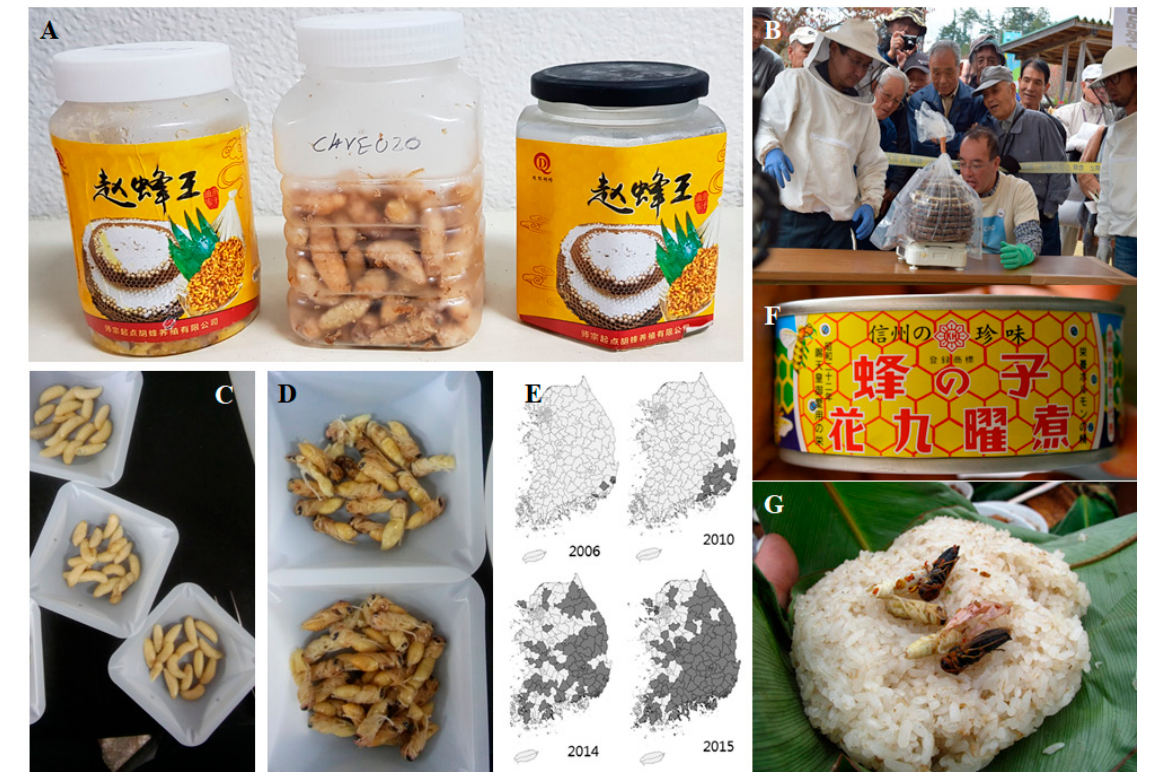
Figure 1. ( A ) bottled hornet larvae sold in China; ( B ) hebo ( Vespula sp.) contest in which judges evaluate wasp nests by weight in search for the largest nest of domestically raised wasps. [Photo credit: Soleil Ho; source: https://www.splen- didtable.org/story/the-japanese-tradition-of-raising-and-eating-wasps, accessed on 31 August 2019]; ( C ) larvae of Vespa velutina collected from the forest near Andong (Korea); ( D ) pupae of Vespa velutina collected from the forest near Andong (Korea); ( E ) range expansion of the invasive hornet Vespa velutina in Korea [Source: 19]; ( F ) canned hachinoko (wasp brood) in Japan; ( G ) practice of eating wasps in Yunnan province [Source: http://teaurchin.blogspot.com/2011/10/weird-things- ive-eaten-in-yunnan.html, accessed on 31 August 2019].